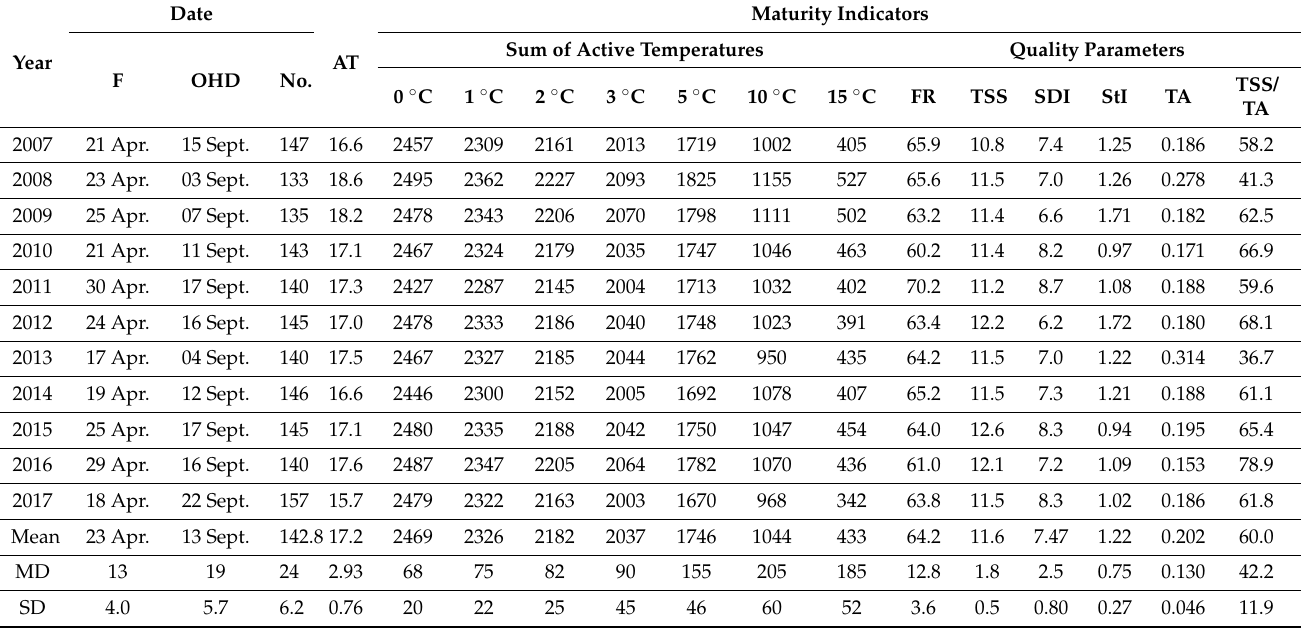
Table 2. Maturity